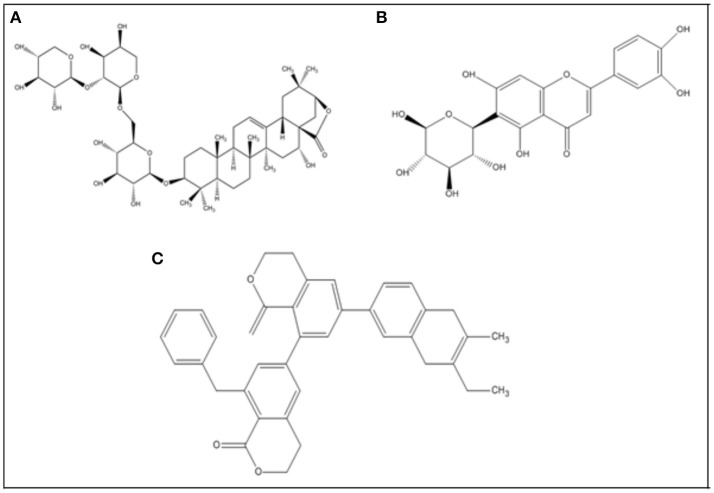
2D chemical structures of selected three top-ranked phytocompounds (A), Albiziasaponin-A (B), Iso-Orientin and (C), Salavadorin.